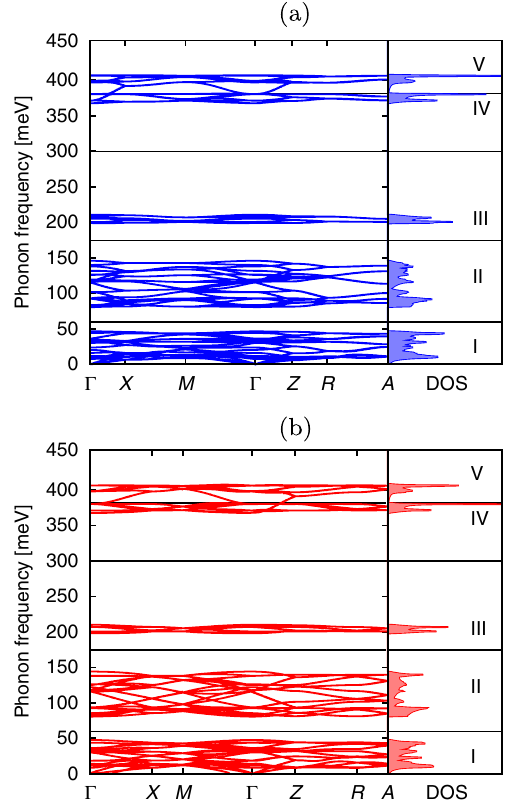
FIG. 7. Vibrational band structure and DOS of (a) Ih and (b) Ic split into crystal modes (I), libration modes (II), molecular O-H bending modes (III), and molecular O-H antisymmetric and symmetric stretching modes (IV and V, respectively).